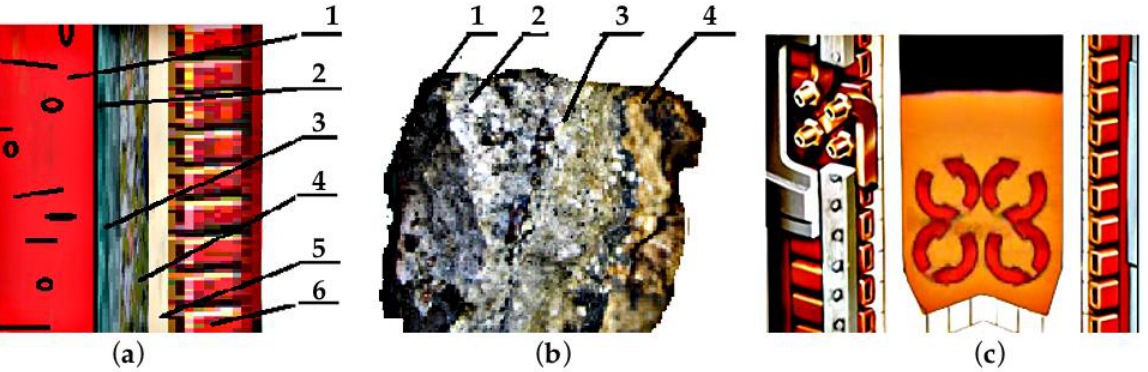
Figure 3. Induction furnace lining layers: ( a ) layer layout: 1 — liquid melt, 2 — slagged layer, 3 — sintered layer, 4 — intermediate layer, 5 — unaltered (loose) layer, 6 — furnace inductor; ( b ) knocked-out lining sample: 1 — slagged layer, 2 — sintered layer, 3 — intermediate layer, 4 — virtually unchanged layer consisting of quartzite bonded with boric acid; ( c ) scheme of melt mixing.